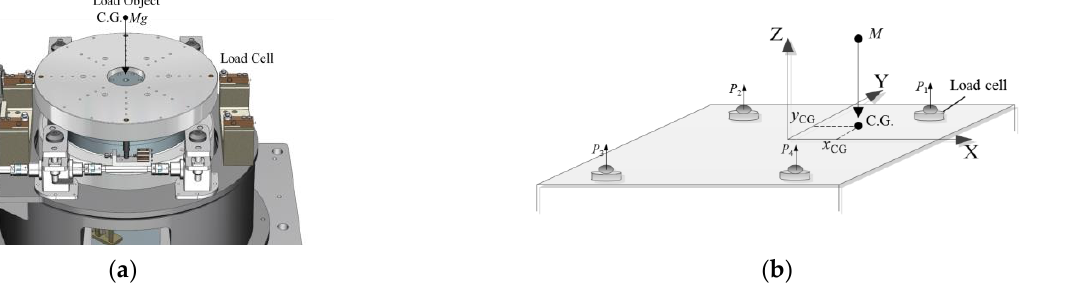
Figure 1. ( a ) The effect picture of the mass centroid measurement mechanism. ( b ) The schematic diagram of the mass centroid measurement.